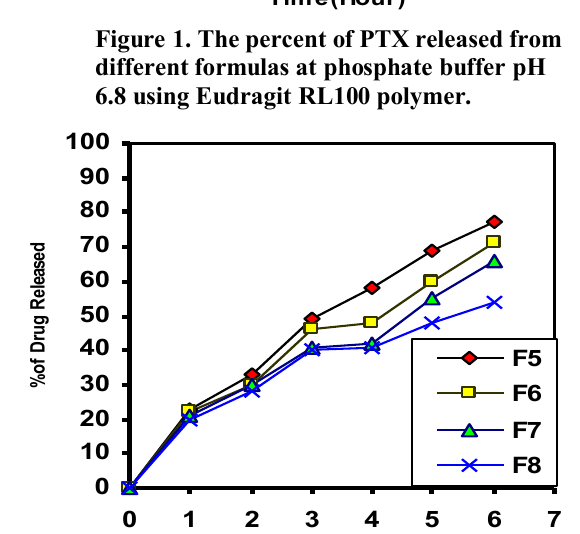
Figure 2. The percent of PTX released from different formulas at phosphate buffer pH 6.8 using Eudragit RSPM polymer.